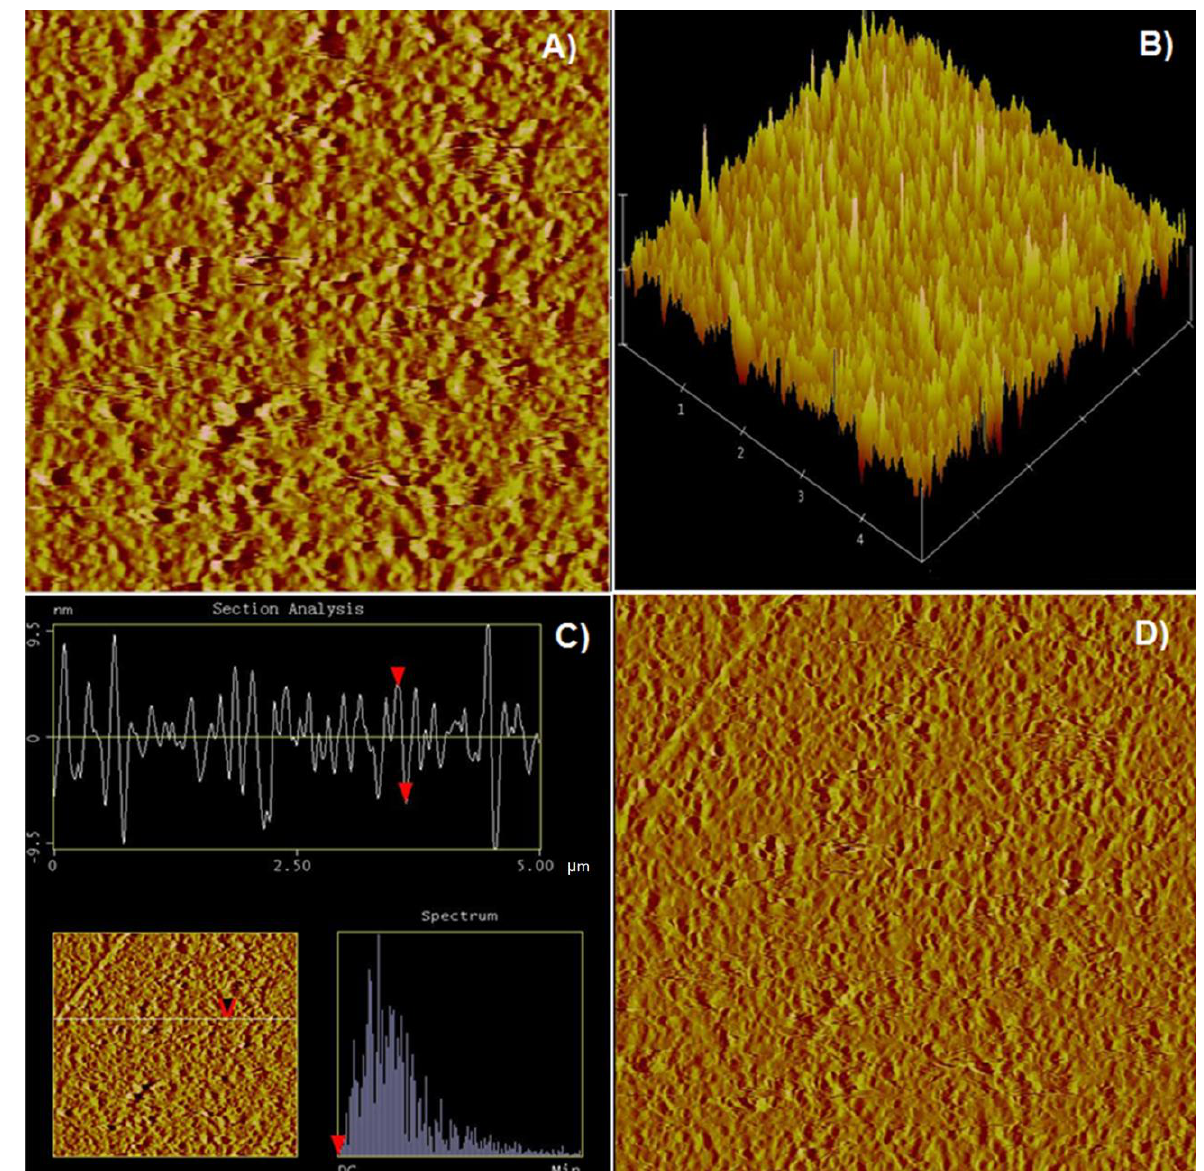
Figure 4. AFM images of a bornite surface soaked in the 1 × 10 − 4 M KEX solution at pH 6 for 10 min. ( A ) The 5 µm × 5 µm height image with a data scale of 20 nm, ( B ) the 3D image, ( C ) the section analysis (the red arrows indicate the top and the bottom of an average asperity) and ( D ) the deflection image with a data scale of 10 nm.